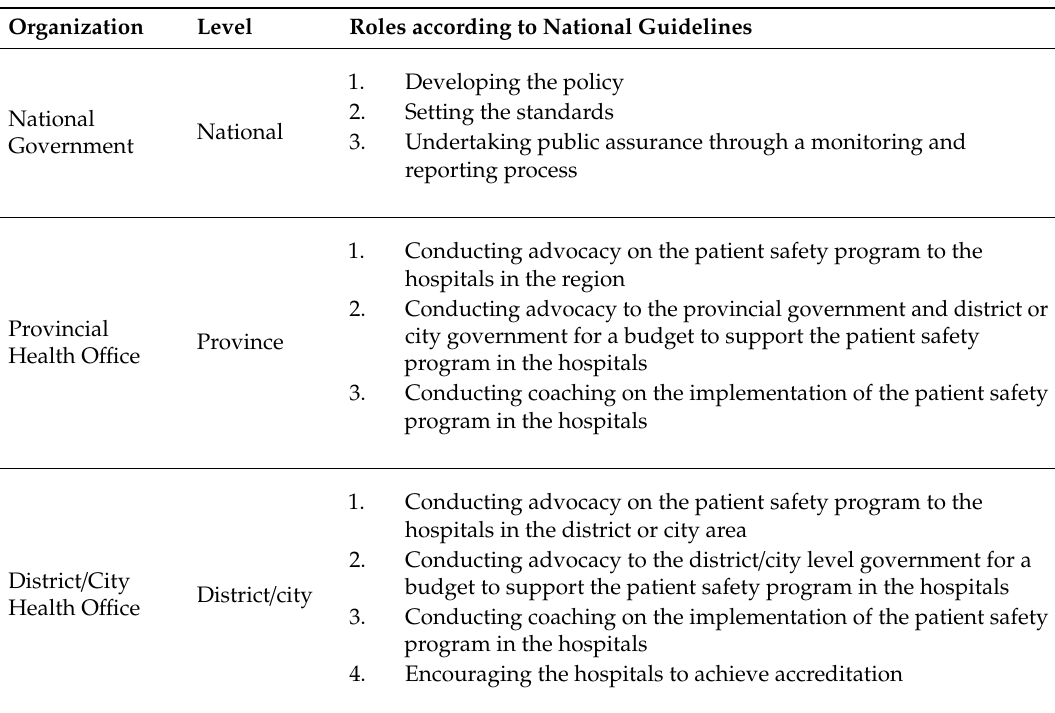
Table 1. The government organizations and their related roles regarding patient safety